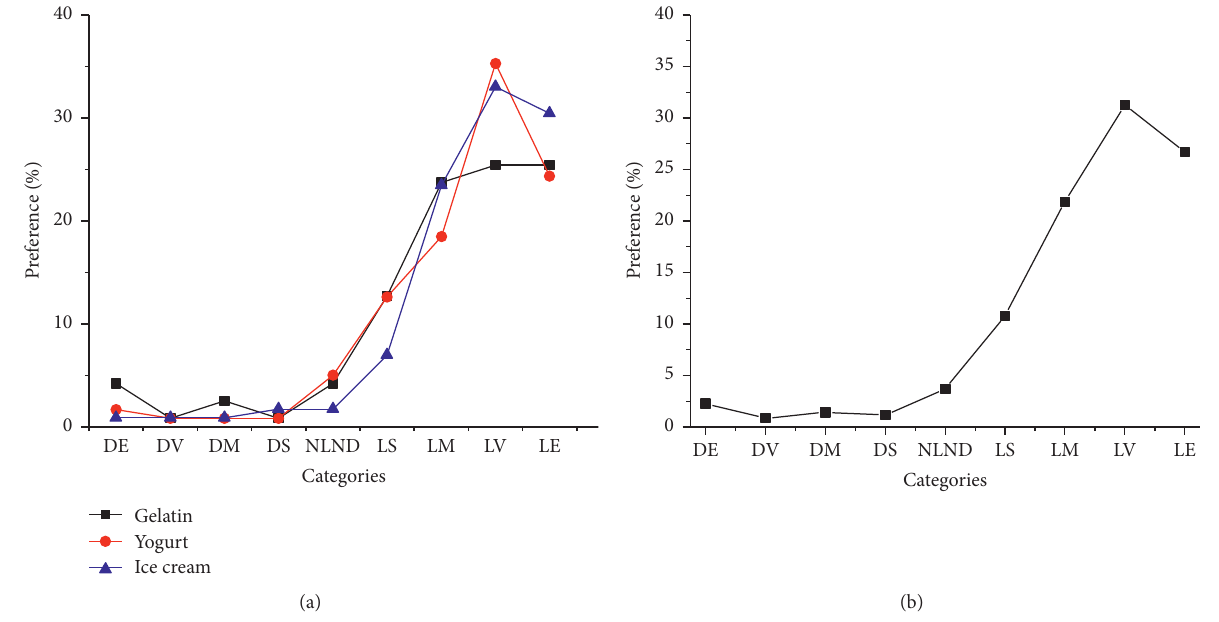
Figure 10: Food preference results. (a) Each dessert group food. (b) Dessert group as a